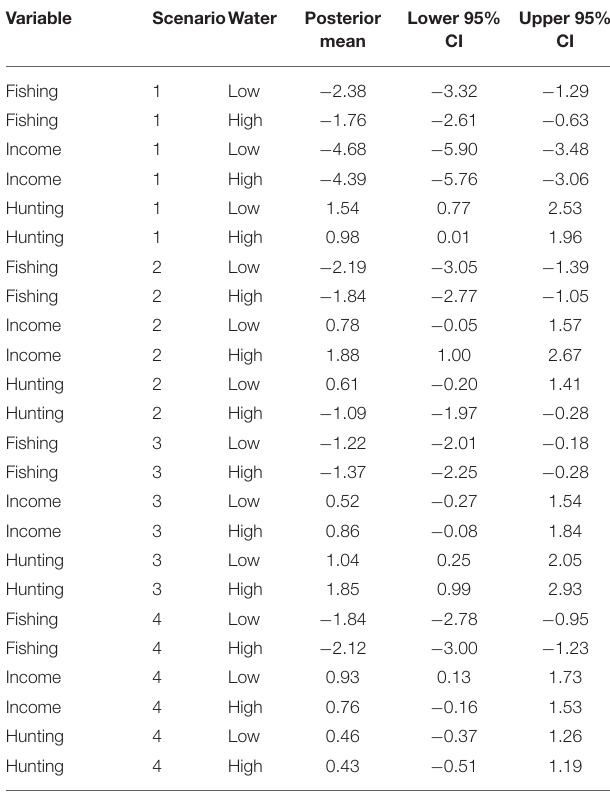
TABLE 5 | We report the posterior mean and the 95% credible interval for the protein sale